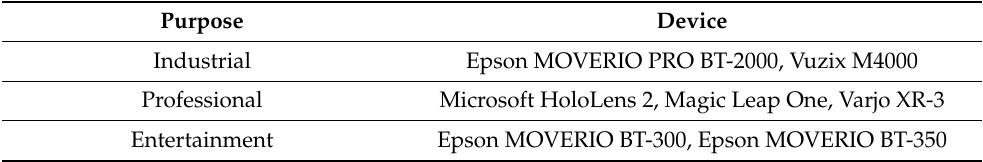
Table 2. HMD considered for this